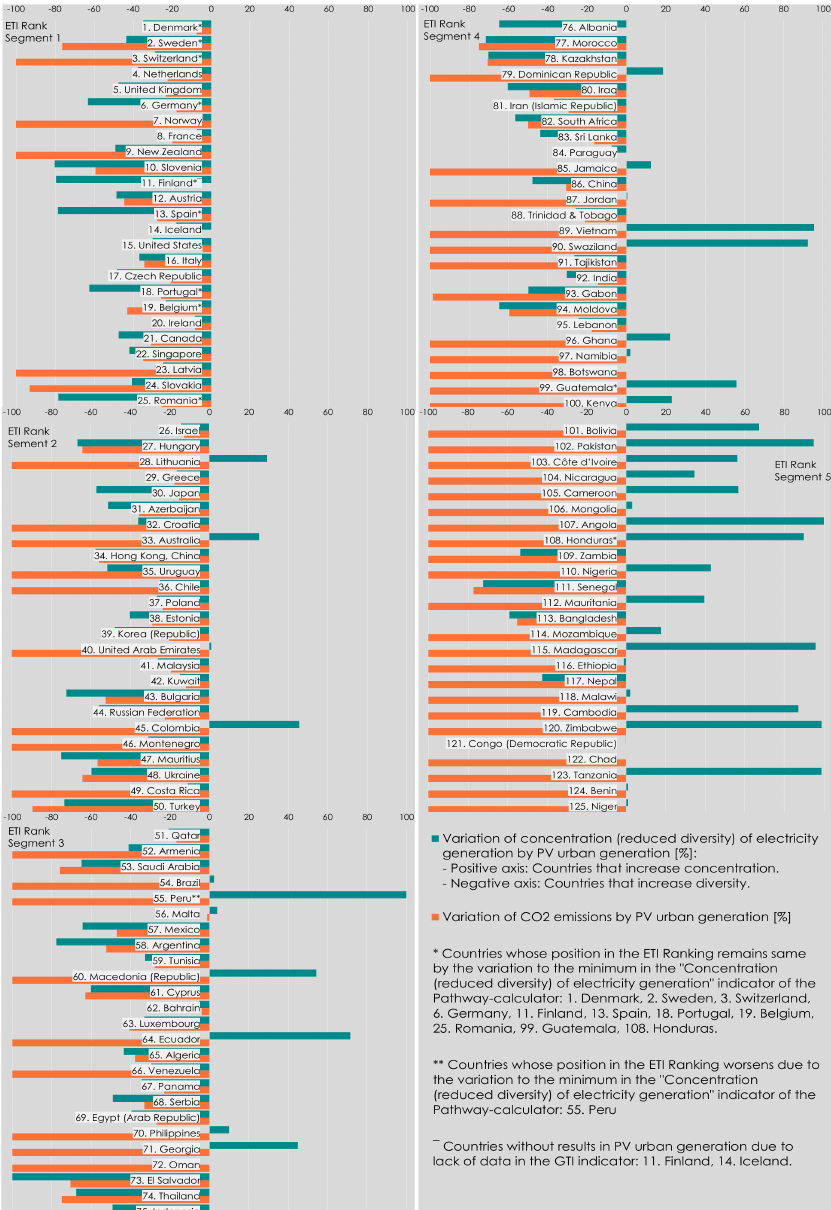
Figure 11. Variation in the concentration of electricity generation due to the increase in urban PV generation in the ETI 2017